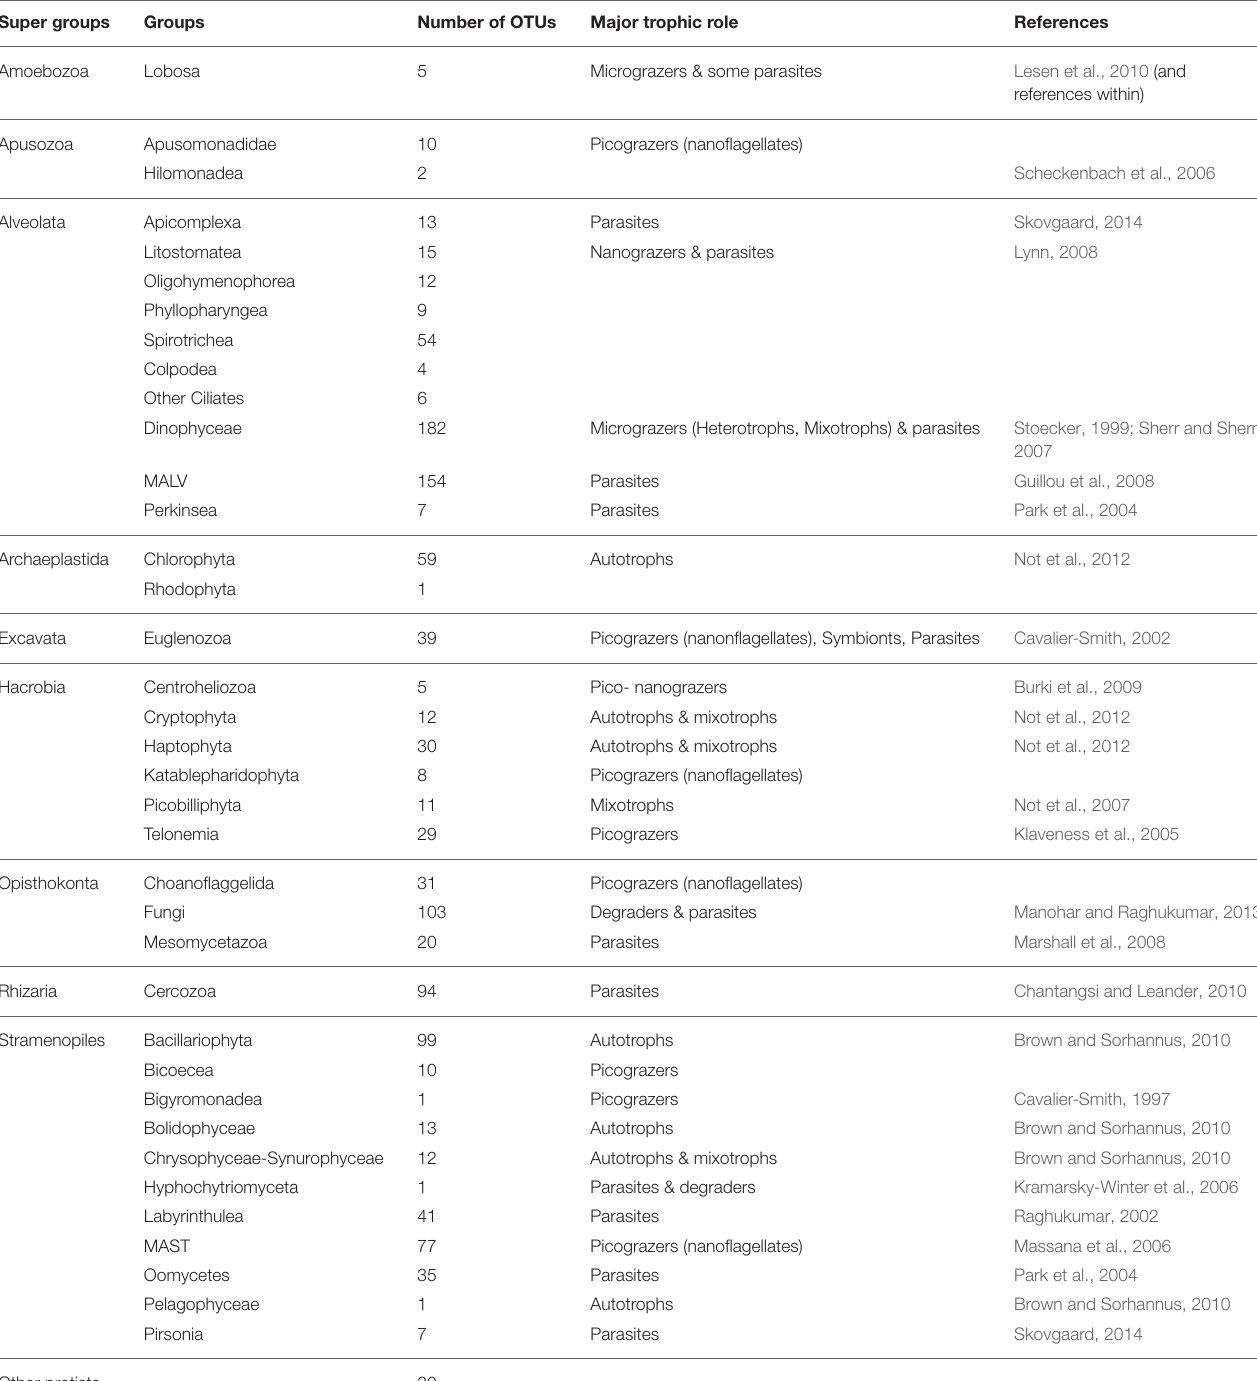
TABLE 1 | Annotated major trophic role, OTUs number at the sampling station, and related references for the super group annotation. Super